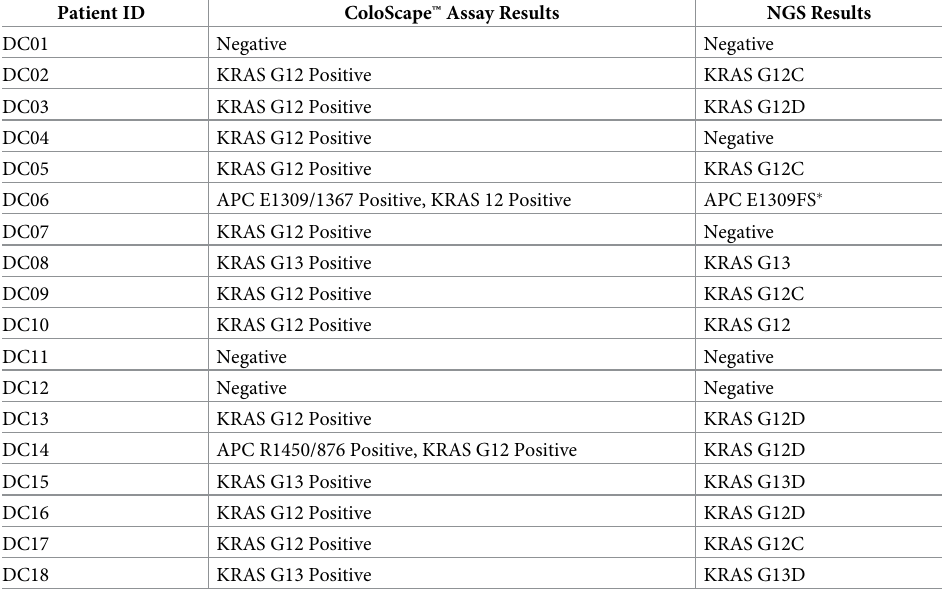
Table 4. Comparison of the ColoScape TM assay and NGS for CRC cfDNA samples. Patient